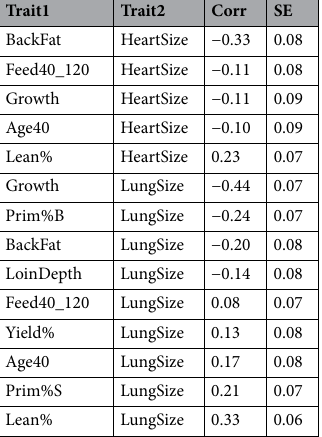
Table 4. Genetic correlation between heart and lung volumes and other relevant traits for Duroc. BackFat backfat at 100 kg’s, Feed40_120 feed intake 40–120 kg’s, Age40 age at 40 kg’s, Growth average daily gain from 40 to 120 kg’s, Lean% lean meat % (incl. head), Prim%B primal % for belly, LoinDepth loindepth at 100 kg’s, Yield% yield % for carcass (incl. head), Prim%S primal % for